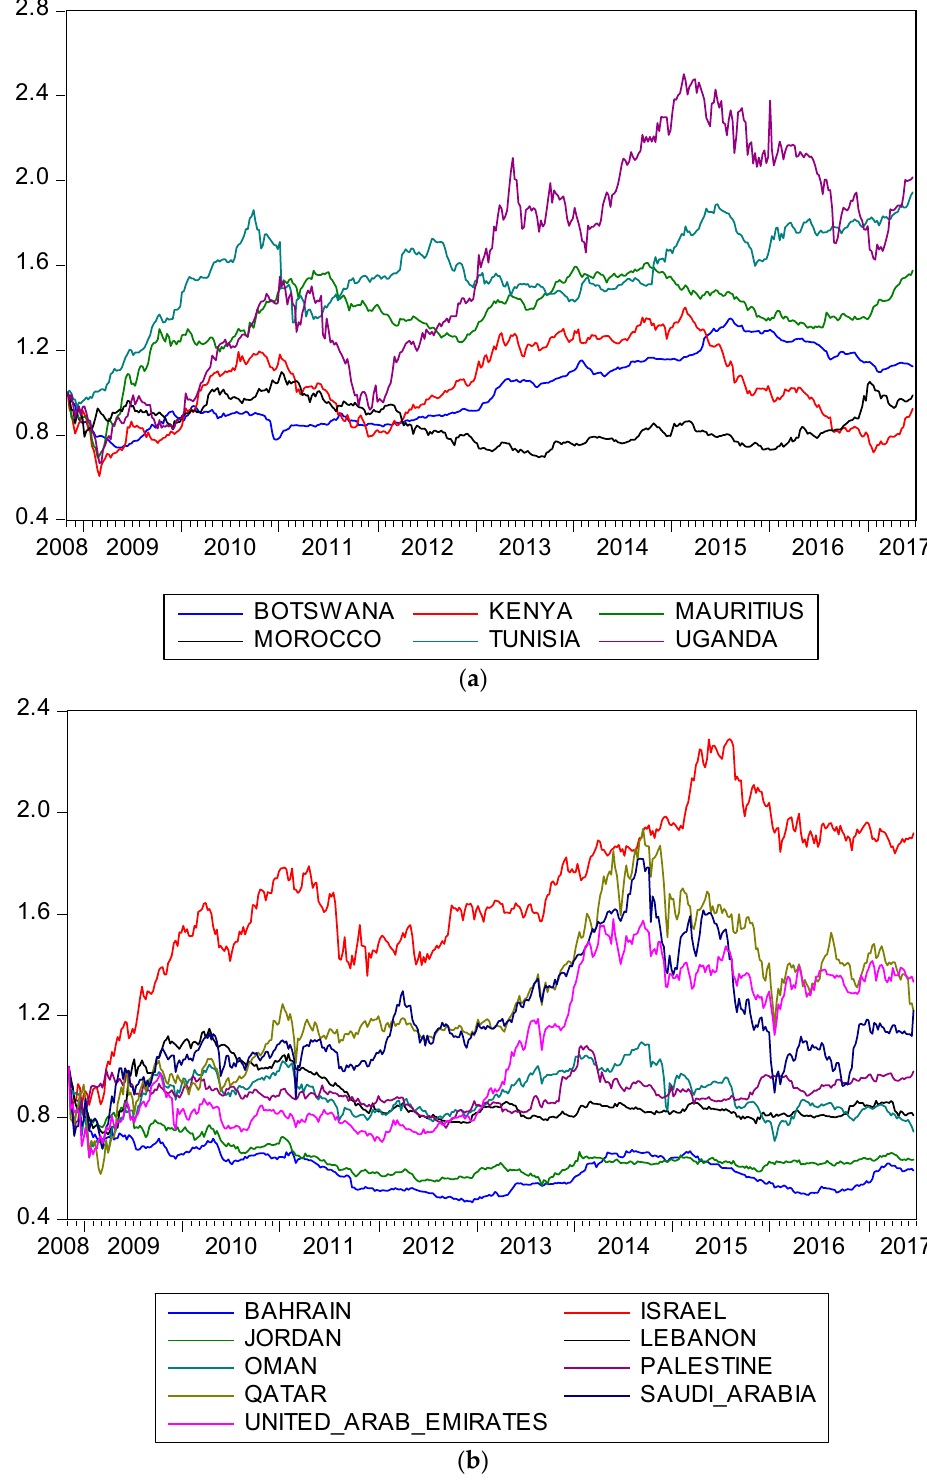
Figure 3. ( a ) African stock indices in the periods after the launch of the Fed’s unconventional monetary policy (QE and post-QE periods); ( b ) Middle Eastern stock indices in the period after the launch of the Fed’s unconventional monetary policy QE (QE and post-QE periods).